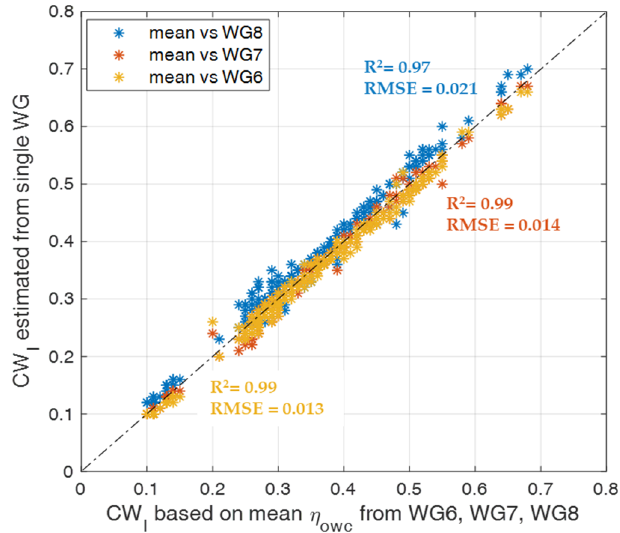
Figure 4. Capture width of the OWC chamber, CW I , estimated with the free surface level η owc obtained as the average of measurements at WG6, WG7 and WG8 vs. direct estimation of CW I based on measurements from a single WG: WG6 ( yellow ), WG7 ( orange ) and WG8 ( blue ).